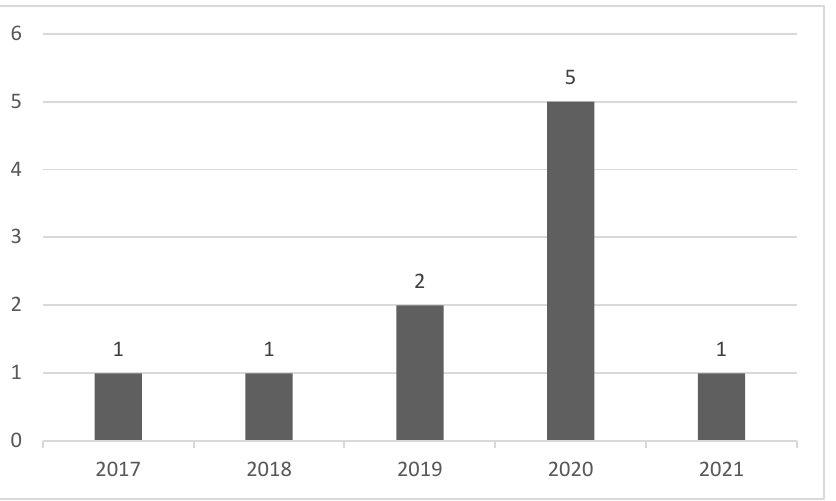
Figure 3. S elected papers per-year distribution. Figure 3. Selected papers per-year